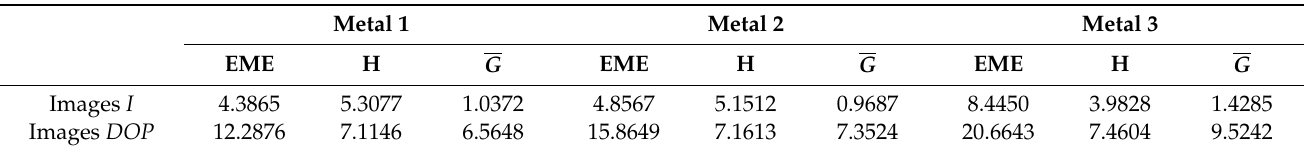
Table 1. Quality evaluation of experimental images in low-visibility underwater scenes. Information entropy average